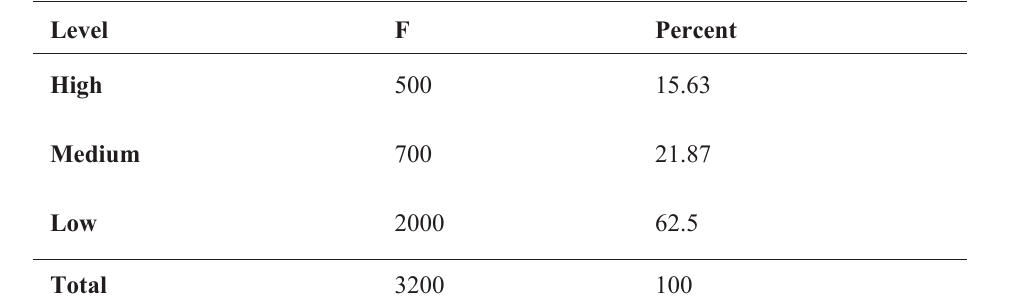
Table.4 Level of